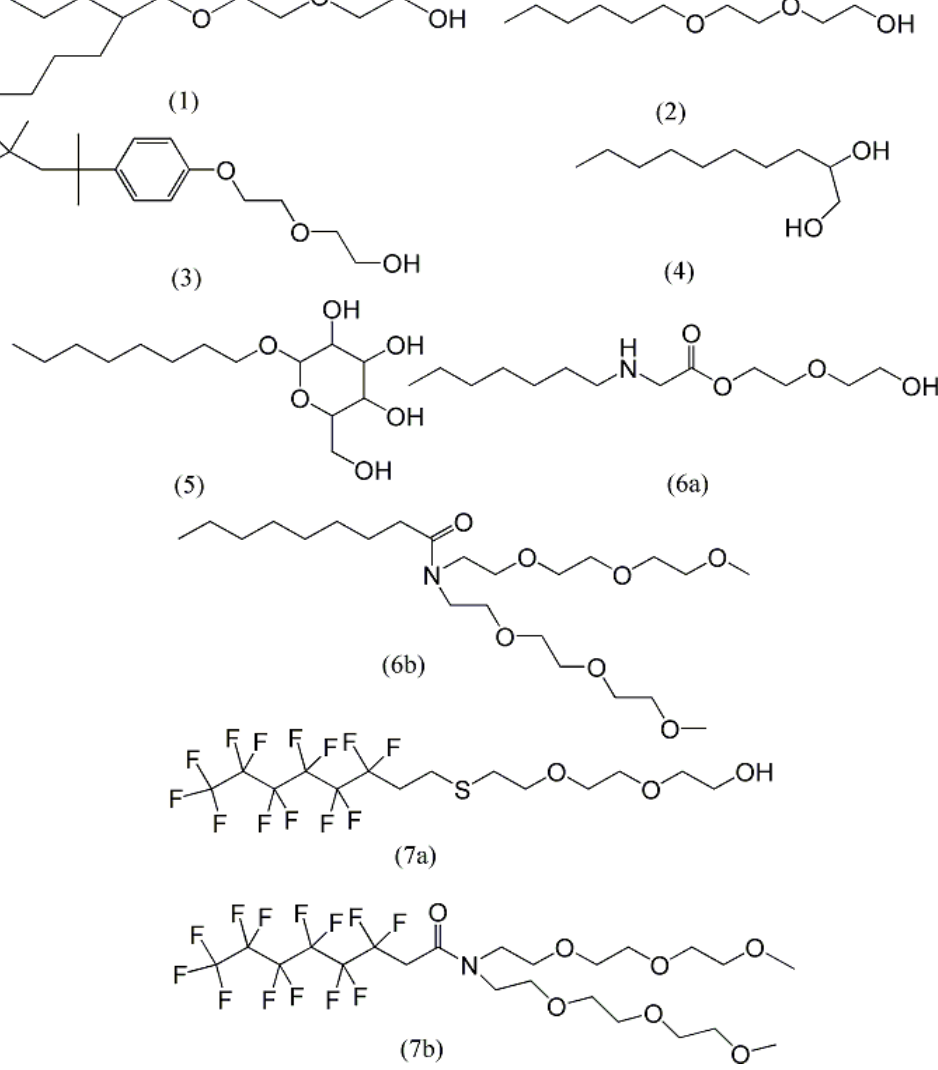
Figure 1. Representative structures of the seven nonionic surfactant classes used by Huibers et al. to predict the cmc for a series of 77 surfactants [30]: (1) branched alkyl ethoxylates (2) linear alkyl ethoxylates (3) octylphenol ethoxylates (4) alkanediols (5) alkyl mono and disaccharide ether and esters (6a) ethoxylated alkylamines (6b)